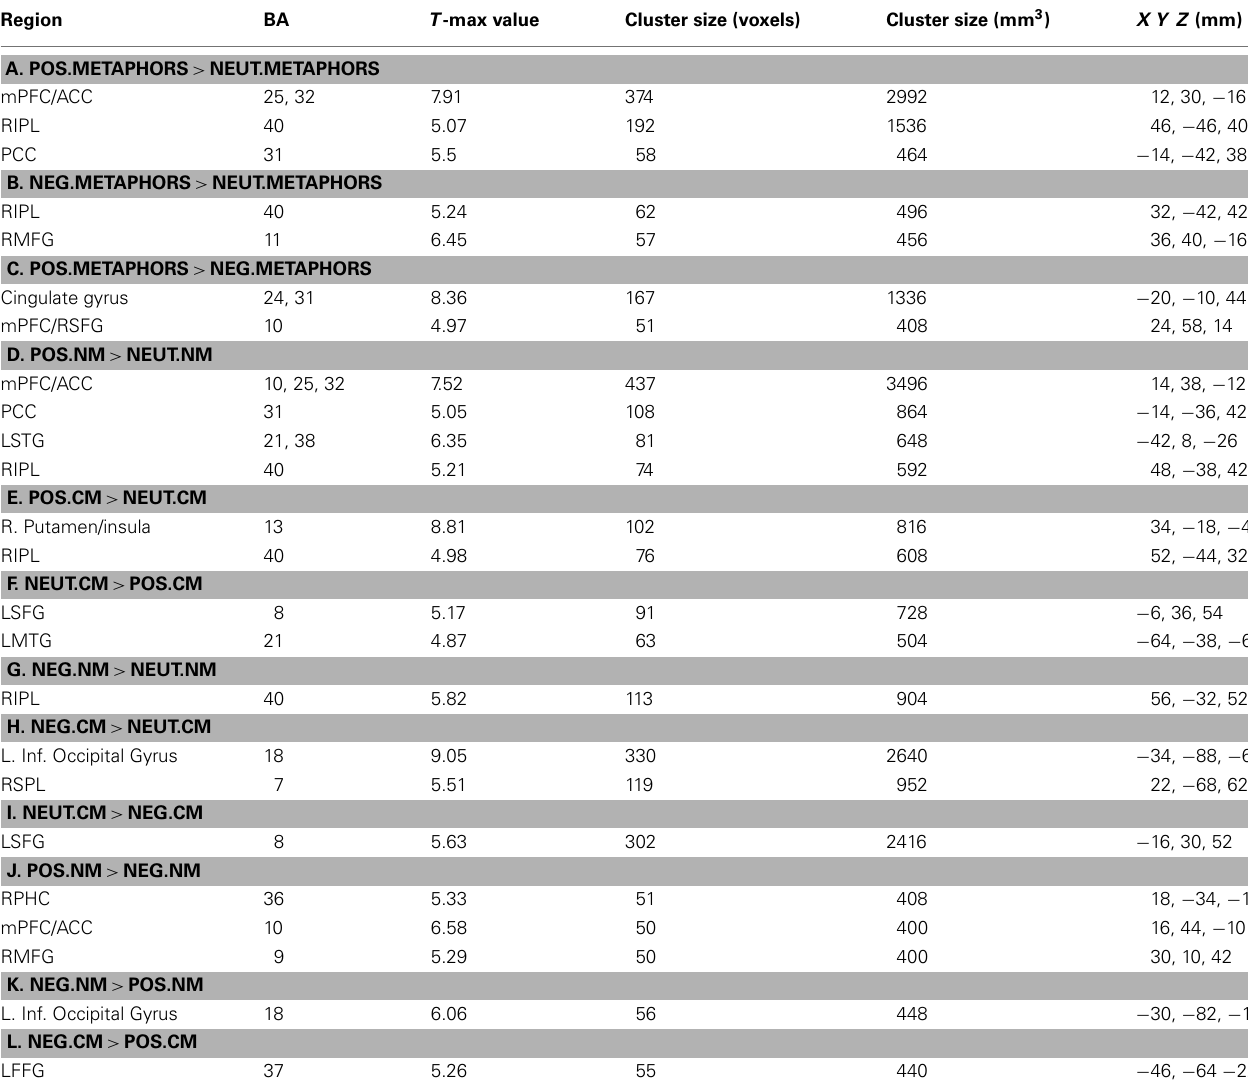
Table 1 |Whole-brain contrasts showing clusters of activation at a threshold of p < 0.001 uncorrected, and with cluster size of at least 50 voxels or 400mm 3 in